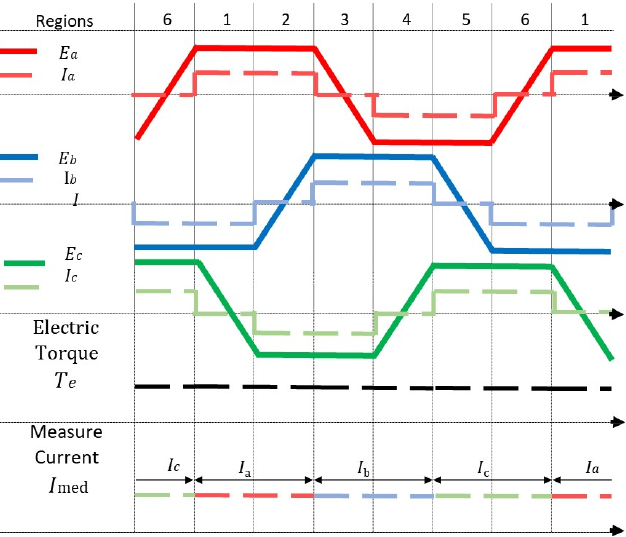
Figure 1. Waveforms of trapezoidal voltages, currents, torque and current observed by the controller of a BLDC motor in 120° Six-Step operation mode.